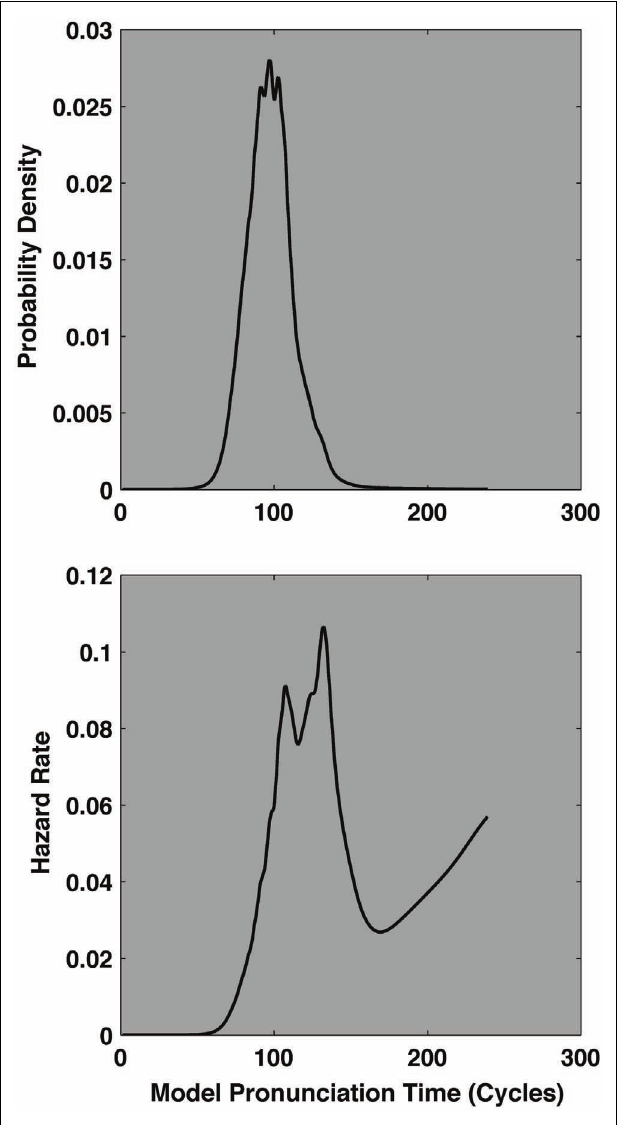
FIGURE 8 |The top plot depicts the probability density function of the synthetic pronunciation times for the CDP ++ model ( N = 32,263, personal communication, Conrad Perry,April 29, 2012). The bottom plot depicts the hazard function for the same data set.The multiple modes in the probability density and the distinct peaks in the hazard function seem to indicate the model expresses distinct processing regimes and very stable